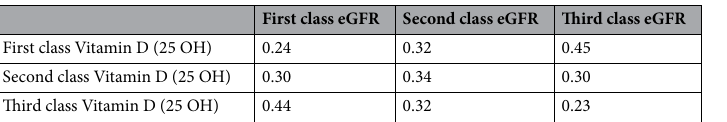
Table 3. Posterior probability of the eGFR indicator given the vitamin D level obtained by training the Bayesian network using routine blood test